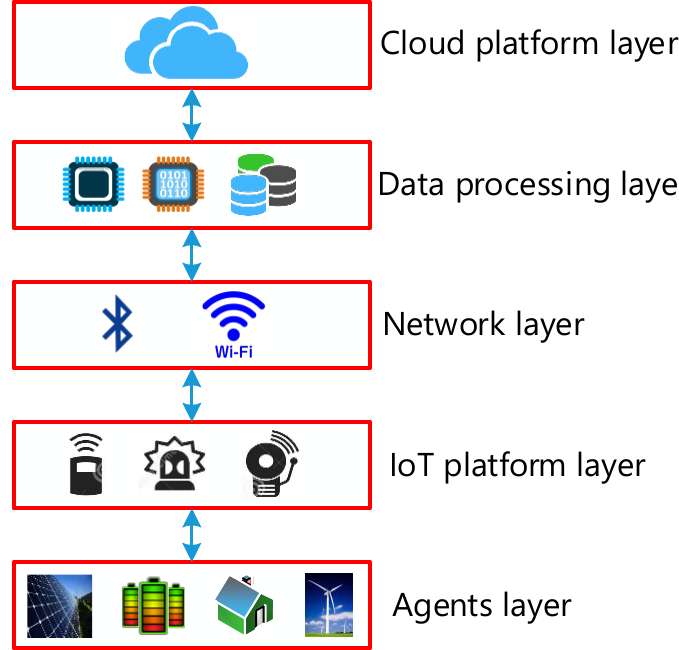
Figure 8. Proposed Internet of Energy platform architecture.